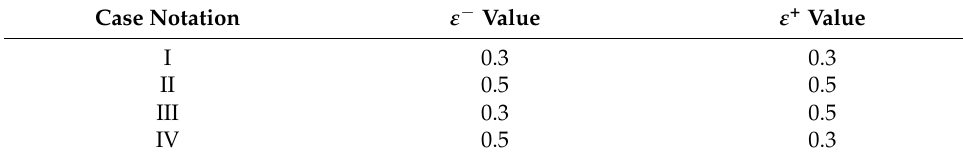
Figure 9. Two-dimension Uncertainty Sensitivity Analysis. Table 7. Variation magnitude analyze situations.